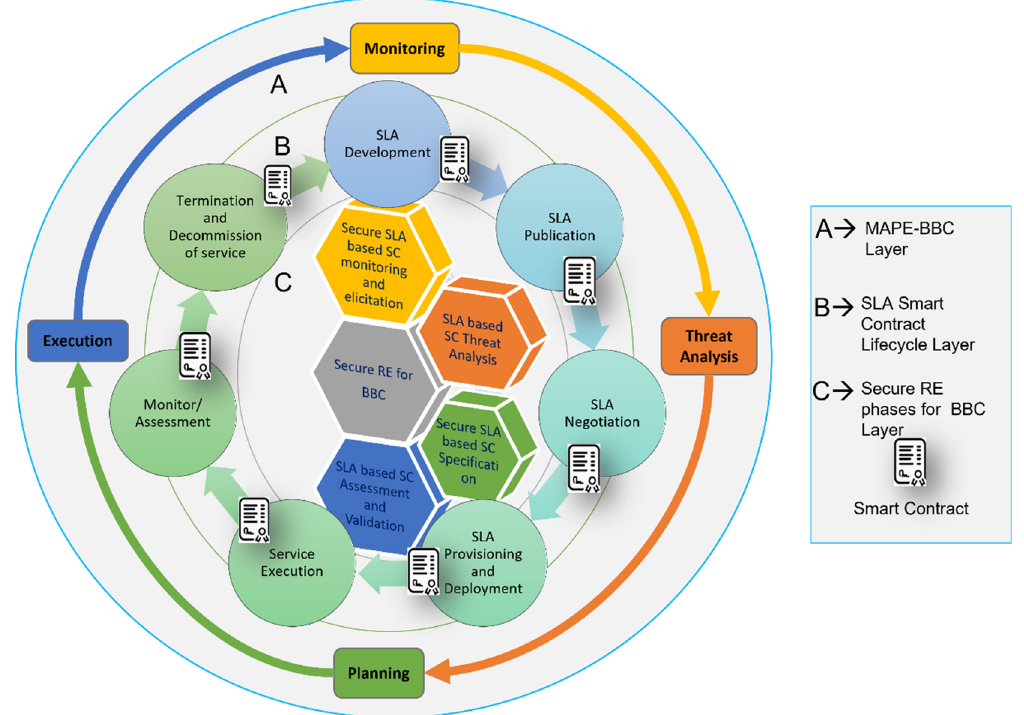
Figure 1. The MAPE-BBC based secure RE for SLA smart